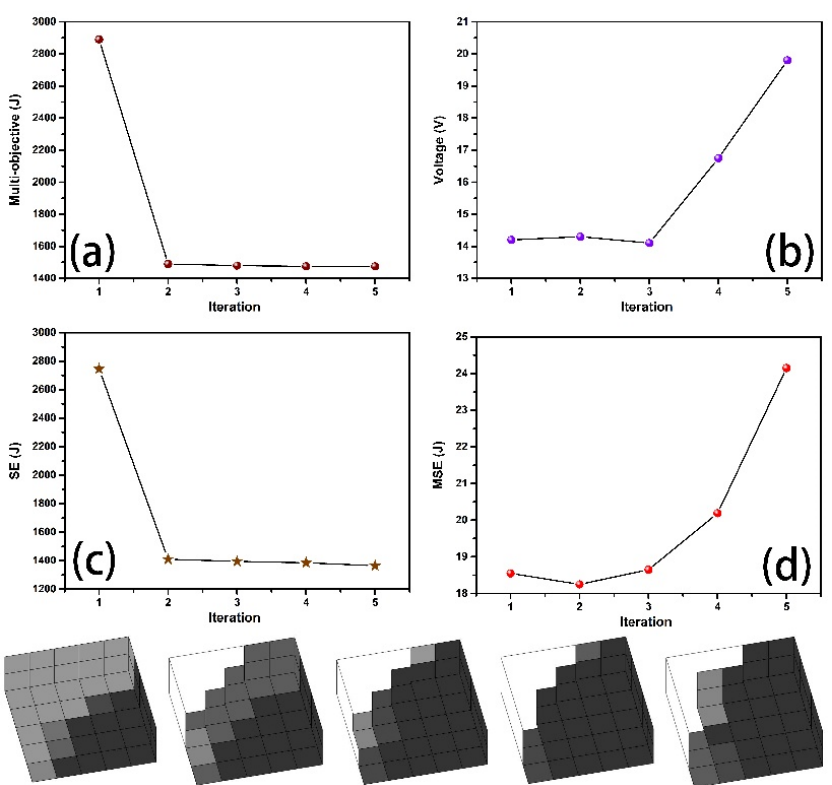
Figure 6. Multi-objective optimization iteration diagram and model shape change diagram of mutual strain energy (MSE)–strain energy (SE). ( a ) Multi-objective figure. ( b ) Voltage output ( c ) SE value ( d ) MSE value.